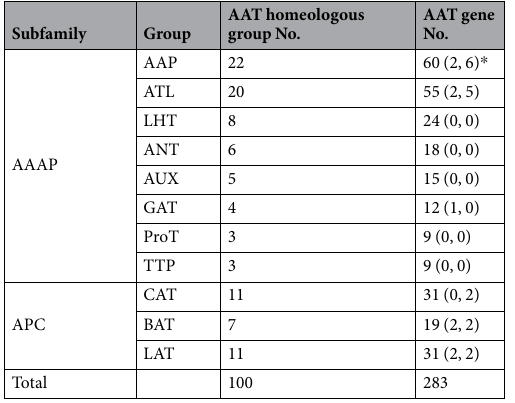
Table 1. Identification of amino acid transporters in wheat. * (pseudogene, missing